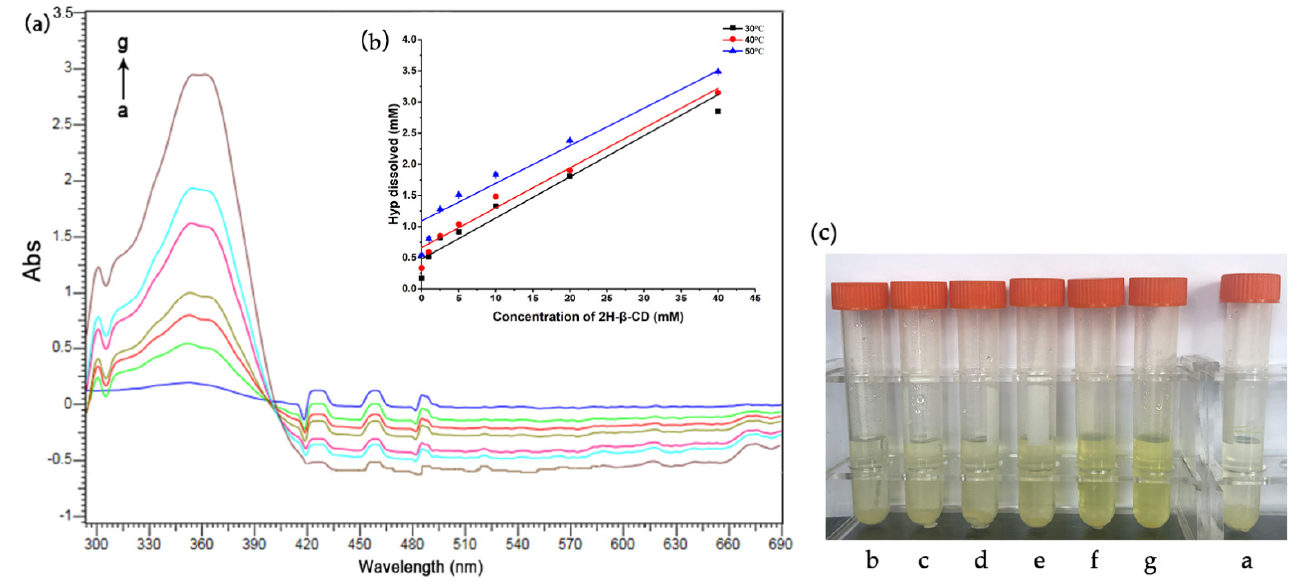
Figure 9. Diagram of the solubility of the Hyp and the IC. ( a ) UV–vis spectral changes of Hyp (sufficient) upon addition of 2H- β -CD at 40 ◦ C; the concentration of 2H- β -CD (a–g): 0, 1, 2.5, 5, 10, 20, and 40 mM, respectively. ( b ) Solubility diagrams of Hyp with 2H- β -CD at 30, 40, and 50 ◦ C. ( c ) Experimental diagram of the dissolution degree of Hyp in different concentrations of Hyp at 40 ◦ C; the concentration of 2H- β -CD (a–g): 0, 1, 2.5, 5, 10, 20, and 40 mM, respectively.